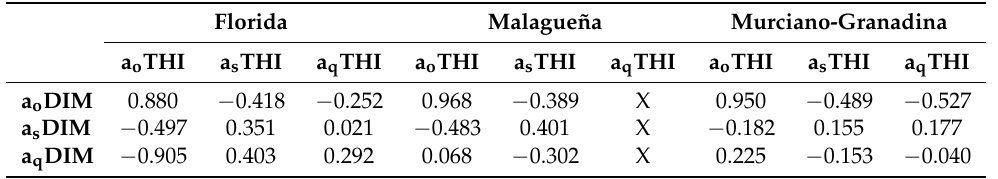
Table 5. Correlation between the Breeding Value for the genetic function elements * estimated along the trajectory of DIM or THI in the three Spanish goat